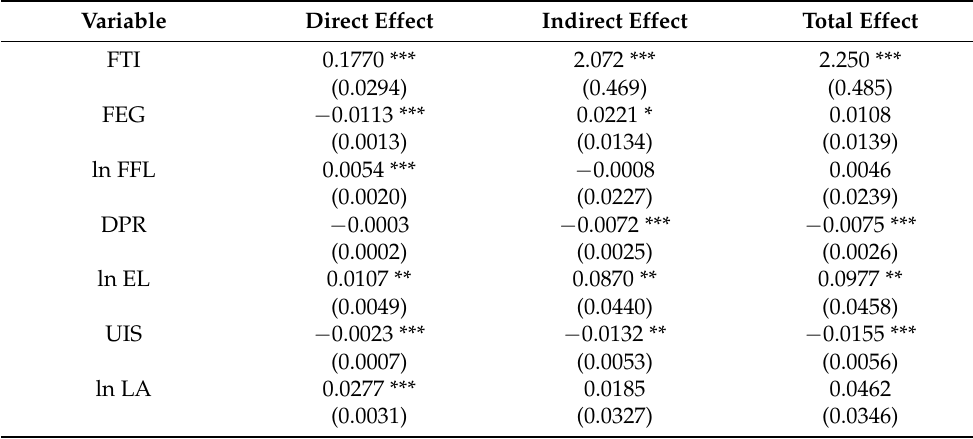
Table 6. Marginal effect decomposition of spatial Durbin